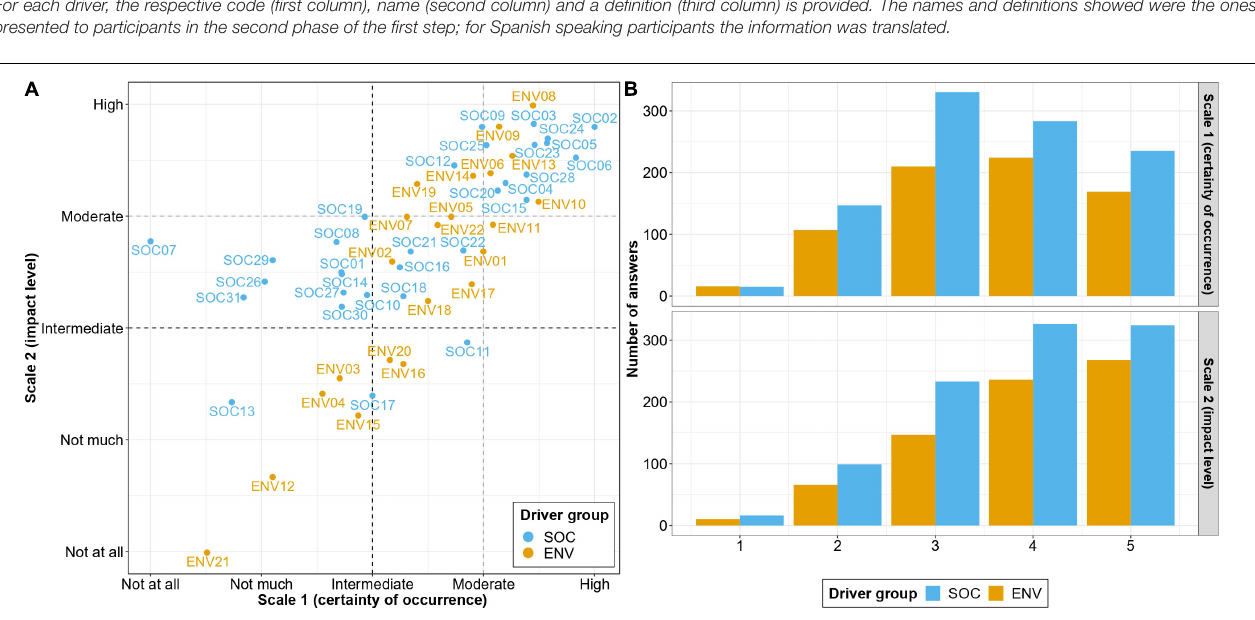
FIGURE 4 | Results of the second step of the scenario scoping approach ( cf . section “Identifying Drivers of Change: Reaching Out Through Online Surveys”). (A) Scatterplot of individual environmental (orange) and socio-economic (blue) drivers along the level of certainty and impact based on a five level likert scale. (B) Number of answers received per level of likert scale (being 1 = Not at all; 2 = Not much; 3 = Intermediate; 4 = Moderate; 5 = High) for the environmental (orange) and socio-economic (blue) drivers